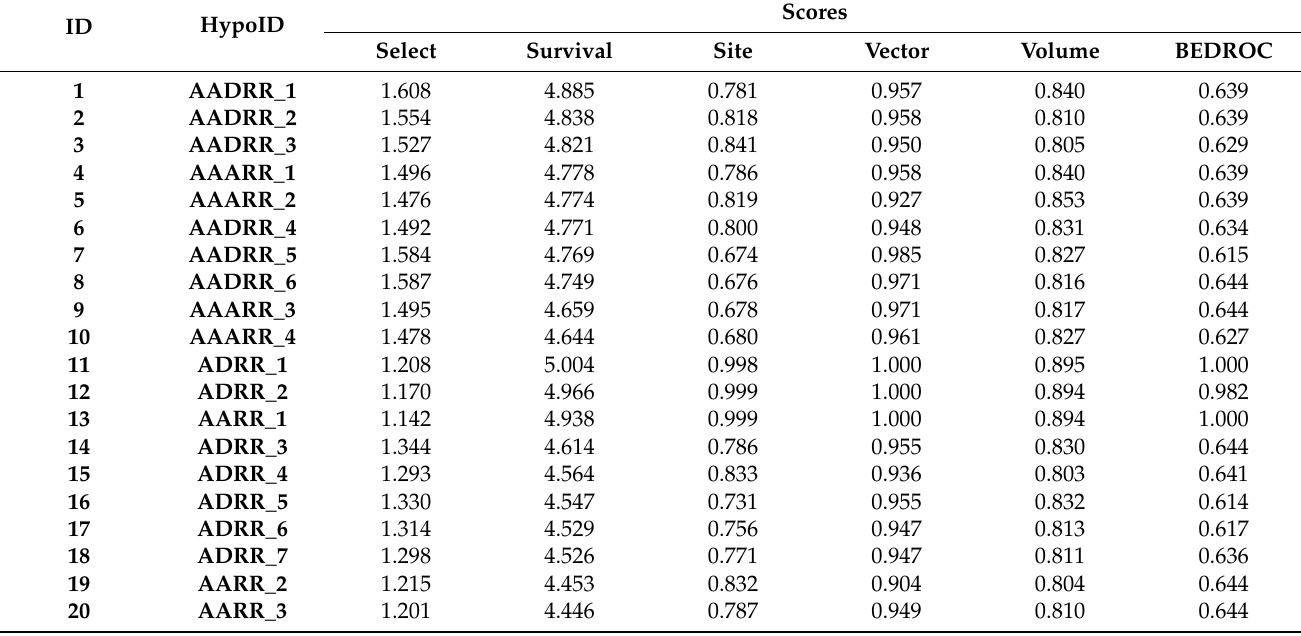
Table 2. Pharmacophore model generated by PHASE